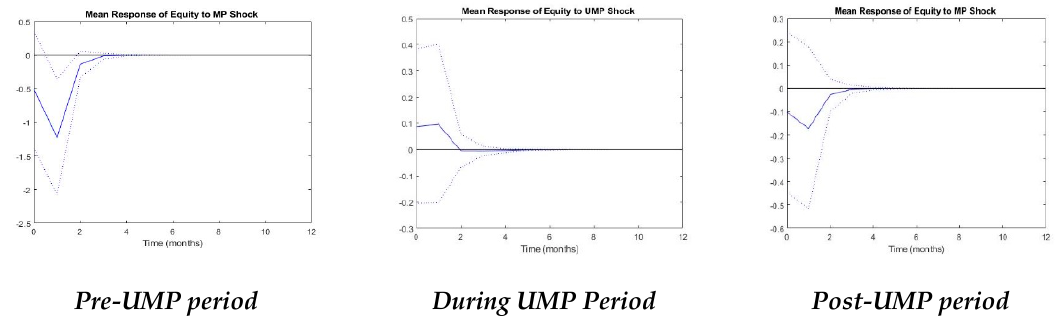
Figure 7. Mean responses of equity prices in Asian developing economies to monetary policy shocks in pre-UMP, during UMP, and post-UMP periods.